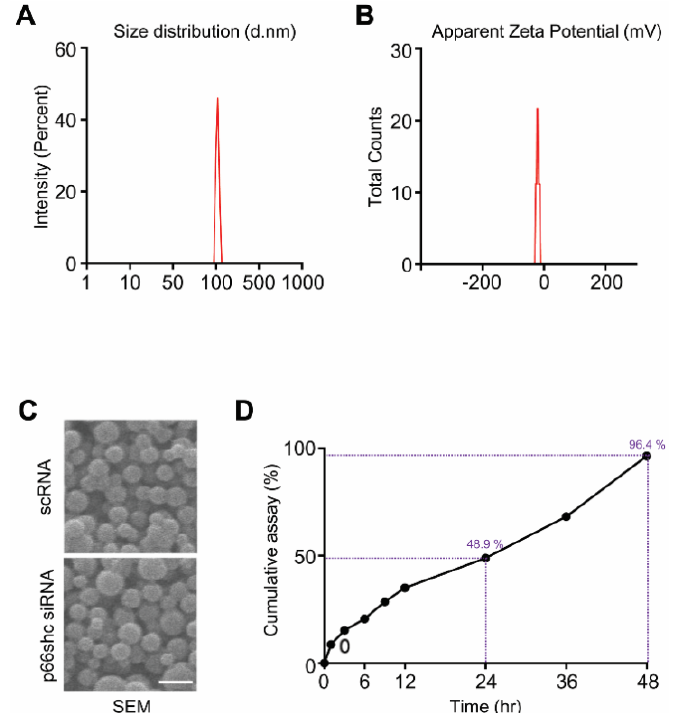
Figure 1. Characterization of p66shc siRNA-PLGA NPs. p66shc siRNA-PLGA NPs were prepared by briefly sonicating the PLGA mixture and then examined for ( A ) size (d.nm: diameter in nm); ( B ) zeta potential using the Zetasizer Nano ZS90; ( C ) by scanning electron microscopy; scale bar = 200 nm, and ( D ) the cumulative siRNA release from PLGA NPs.